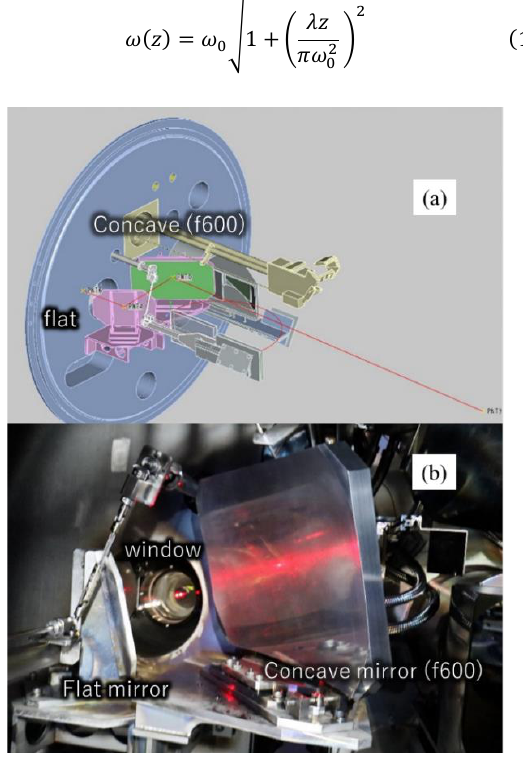
Fig. 4. (a) CAD design and (b) photograph of combination mirrors in LHD vacuum vessel.